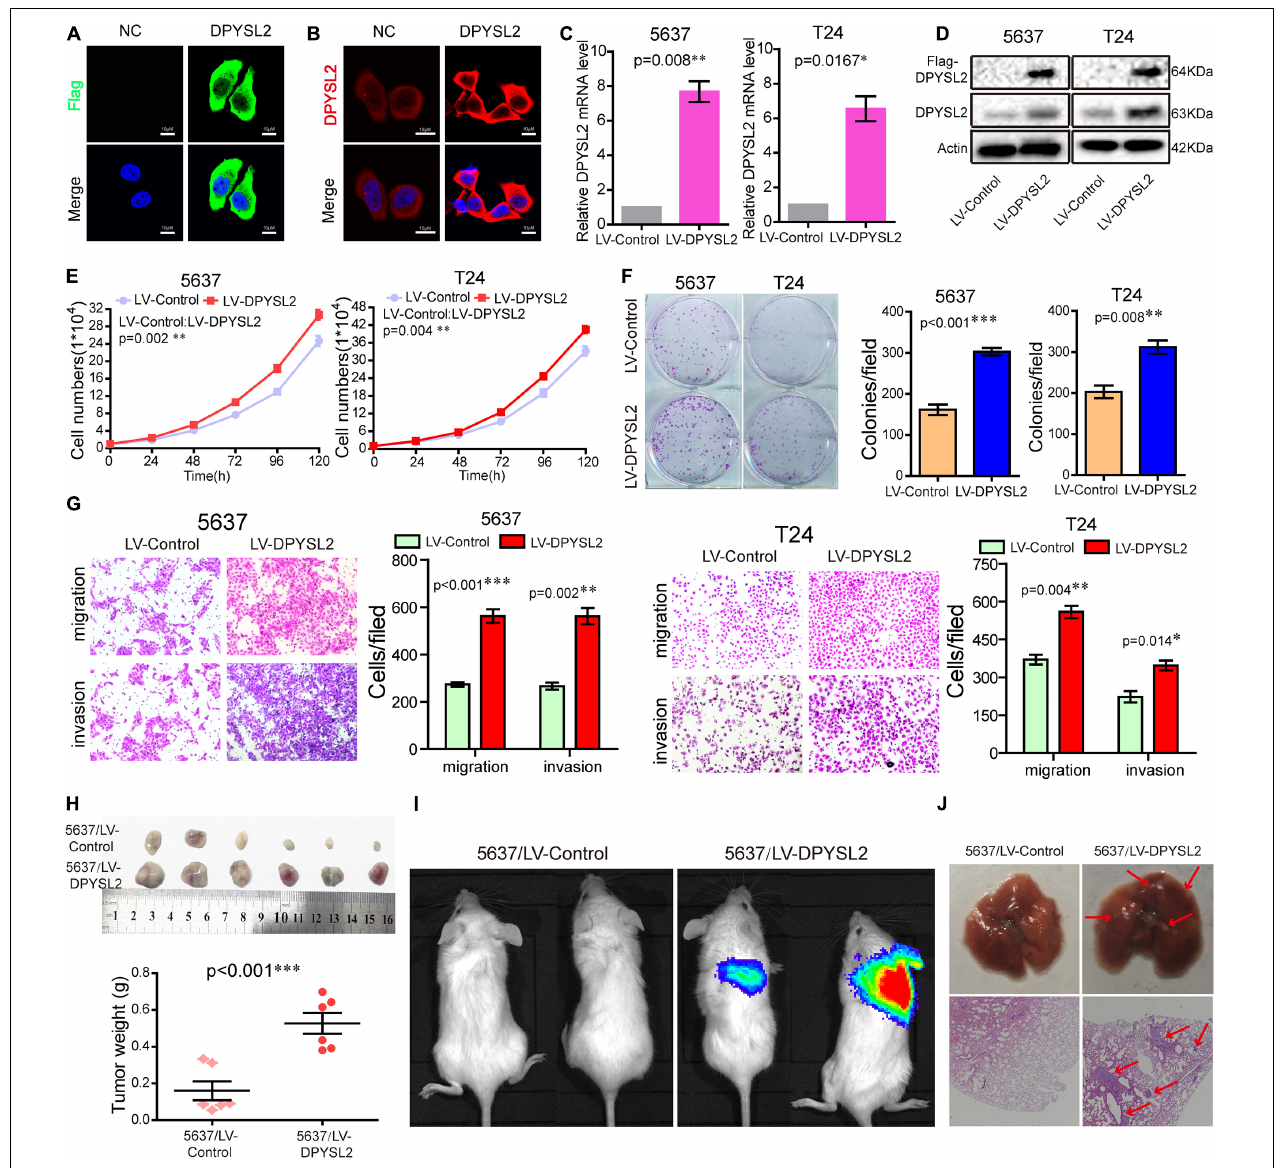
FIGURE 3 | Dihydropyrimidinase like 2 (DPYSL2) overexpression promoted bladder cancer cell proliferation, colony formation, migration, and invasion in vitro , as well as tumor growth and metastasis in vivo . (A,B) T24 cells were transfected with the Flag-DPYSL2 plasmids or negative control. Flag and DPYSL2 were immunostained with anti-Flag (A) or anti-DPYSL2 (B) antibody. Representative images are shown. Magnification 200 × . (C,D) 5637 and T24 cells were stably transfected with empty lentiviral vectors (LV-control) or lentiviral vectors overexpressing DPYSL2 (LV-DPYSL2). qRT-PCR and Western blot analysis were conducted to measure the mRNA and protein levels of DPYSL2. (E–G) Cell proliferation, colony formation, migration, and invasion assays were conducted. (H) NOD-SCID mice were subcutaneously inoculated with 4 × 10 6 LV-control- or LV-DPYSL2-transfected 5637 cells at the left and right armpits ( n = 5/group). Mice were euthanized at 4 weeks after inoculation, and the tumors were collected, measured, and weighed. Data are expressed as the mean ± SEM. * P < 0.05, ** P < 0.01, *** P < 0.001; n = 5. (I) NOD-SCID mice were injected with 2 × 10 6 LV-control- or LV-DPYSL2-transfected 5637 cells through caudal vein ( n = 6/group). At 3 months after injection, each mouse was injected with 0.15 mg/g potassium d-fluorescein through the tail vein. The IVIS 200 imaging system was used to detect luminescence in tumor-bearing mice. (J) Upper panel: Representative images of pulmonary metastases. Lower panel: Hematoxylin and eosin staining of pulmonary metastases. Red arrows indicate